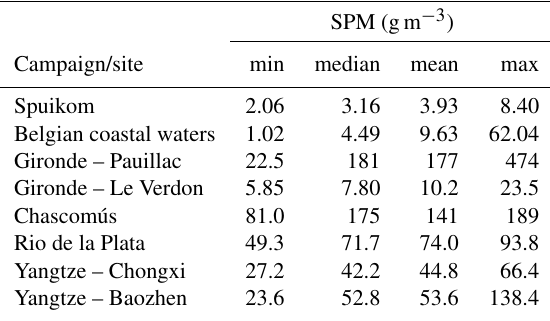
Table 3. Distribution of SPM (gm − 3 ) in each sampling site.